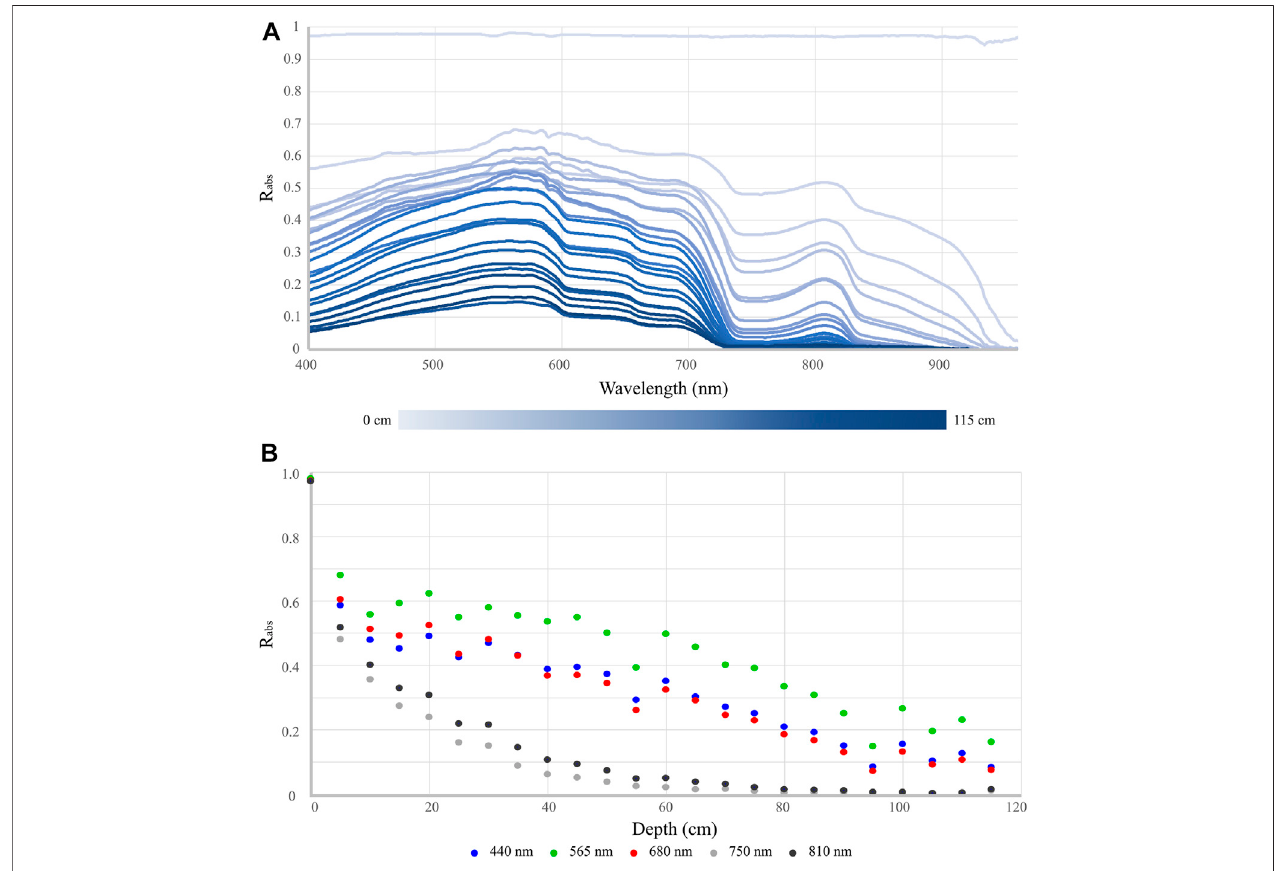
FIGURE6| Effectofthewatercolumnonthere fl ectanceofasubmerged99%Spectralonpanel. (A) EstimatedAbsoluteRe fl ectance(R abs )at5 cmdepthintervals between ∼ 0 and 115 cm. (B) R abs at select VIS (440 nm, 565 nm, and 680 nm) and NIR (750 and 810 nm) wavelengths plotted against panel submergence depth.